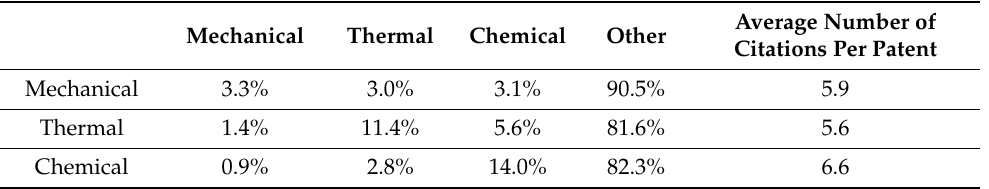
Table 5. Distribution of backward citations per type of citation and citing patent and average number of backward citations per citing